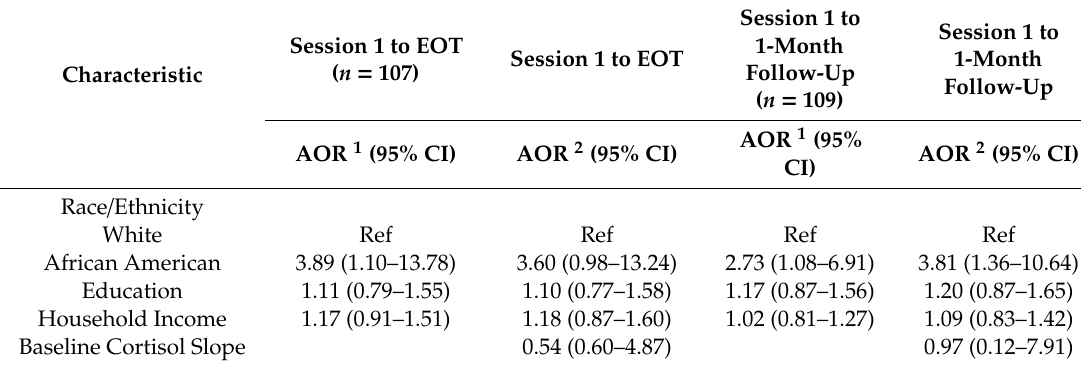
Table 3. Smoking Relapse by Racial / Ethnic